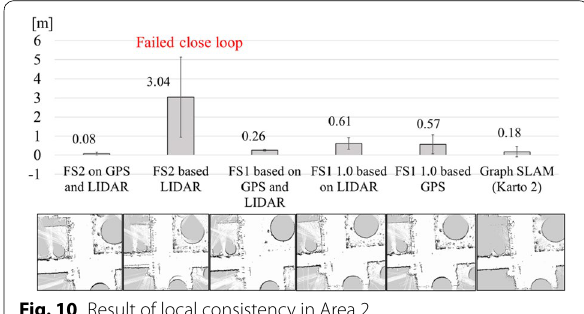
Fig. 10 Result of local consistency in Area 2